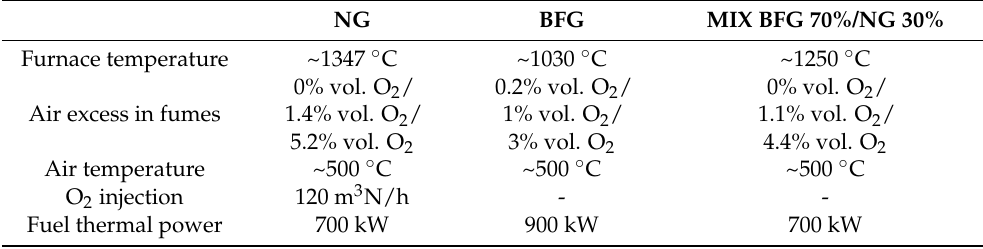
Table 2. Conditions of the experimental